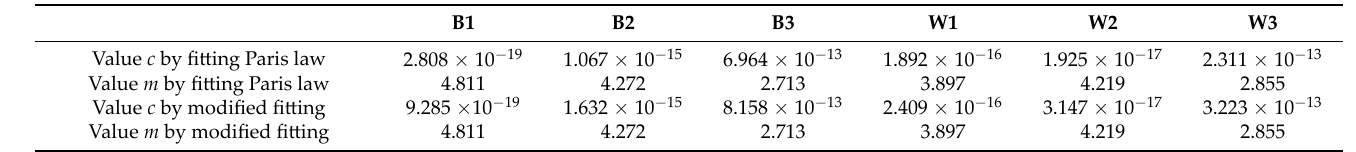
Table 3. Comparison of traditional modified fitting parameters based on Paris theory and modified fitting parameters based on Elber